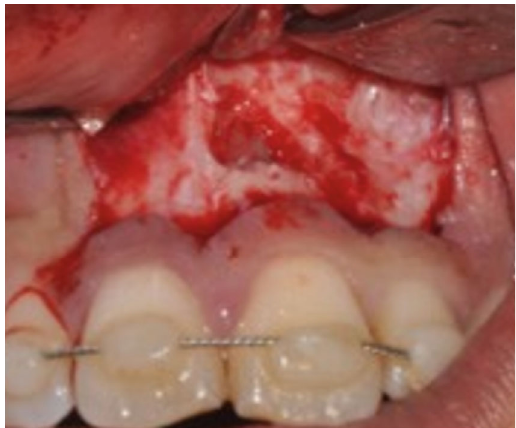
Figure 7: Surgical view of the upper left central incisor during